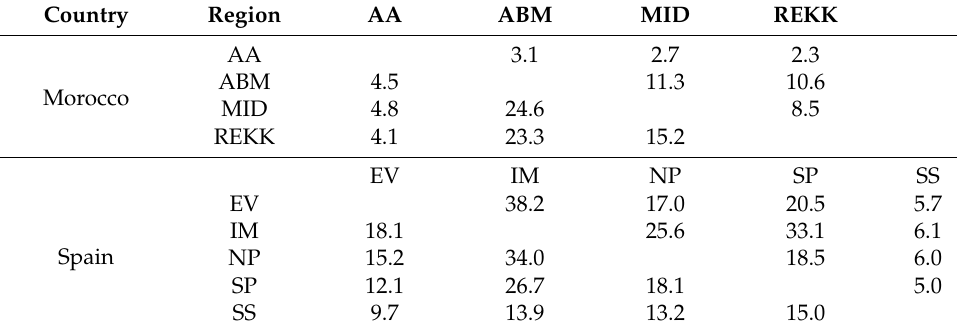
Figure 2. Relative migration networks for Dupont’s lark generated using divMigrate and based on the Nm estimator. Filter threshold was set to 0. Networks were calculated between Spanish regions in the recent past ( a ) and the current ( b ) sampling periods, and between Moroccan regions in the recent past ( c ) and the current ( d ) periods. Thicker arrows and proximity of nodes indicate stronger gene flow. Statistically significant asymmetric gene flows are indicated with an asterisk. Region codes as in Figure 1. Table 5. Estimated number of migrants per generation (Nem) between pairs of regions in Morocco and Spain during the recent past (below diagonal) and the current (above diagonal) periods.